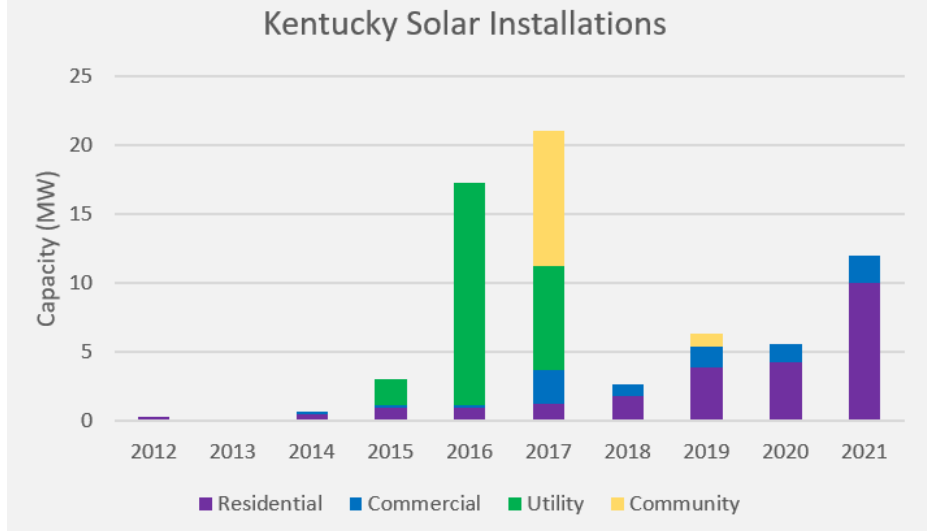
Figure 1. KY Annual Solar Installations by Sector [6].